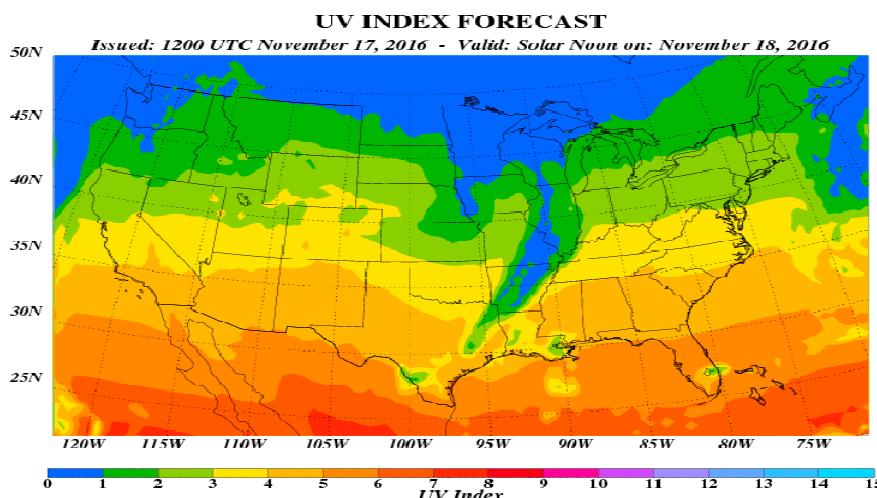
Figure 14. OMPS total column ozone products (in Dobson Units) from MetOp-B GOME-2 (NOAA Version 8 algorithm), NASA EOS Aura OMI (NASA Version 8.6 algorithm) and S-NPP OMPS-NM (NOAA Version 8 algorithm) for 1 June 2015. (Figure courtesy: Lawrence E Flynn, STAR OMPS Ozone team).